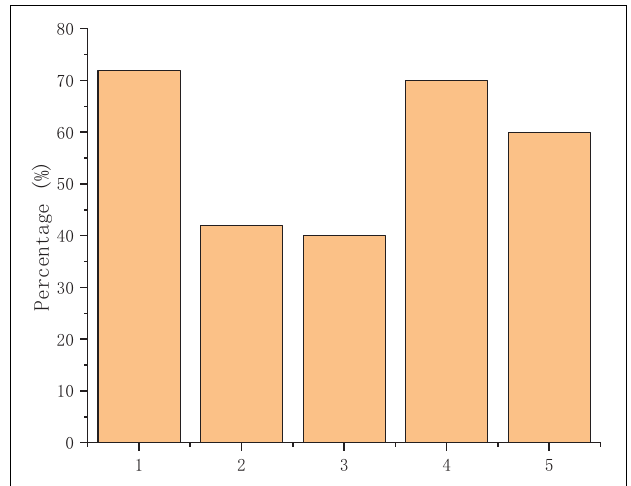
FIGURE 6 | Main functions of the learning platform of MOOCs [(1) assistance in classroom learning; (2) the download of learning materials; (3) discussion and communication with peers; (4) autonomous learning; and (5) submitting homework and examination].